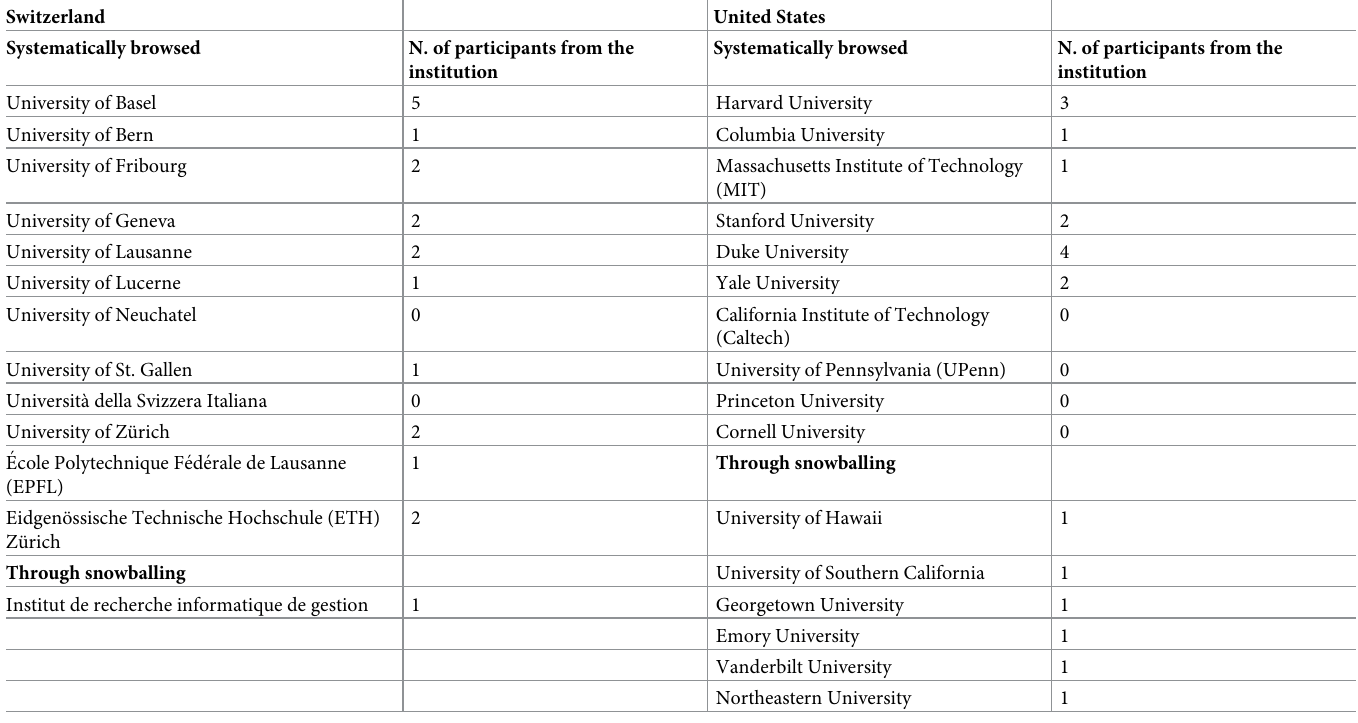
Table 2. Number of participants per selected